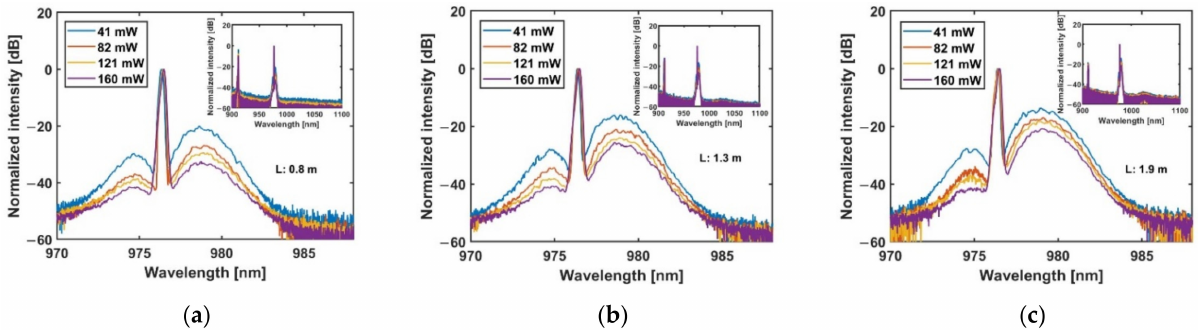
Figure 7. The variations of output spectrum with various seed power corresponding to 0.8-m, 1.3-m, and 1.9-m active fibers ( a – c